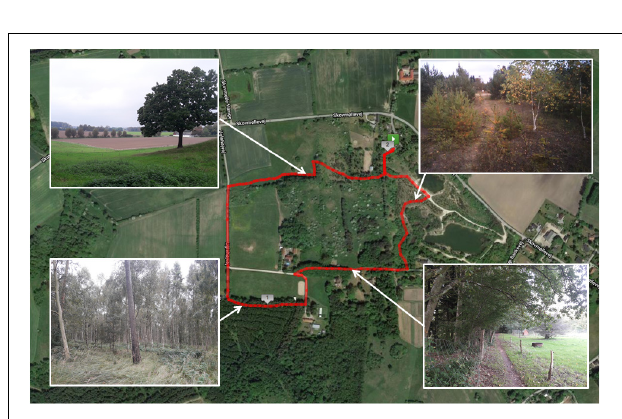
FIGURE 3 | Route map and photographs of the natural environment exposure walk. Aerial map of Myrup, Denmark, where the route for the natural environment exposure walk was selected (marked in red). A rural property located in Myrup was the location of the cognitive testing area and the start/end point for the natural environment route. The route map was created using MapMyRun